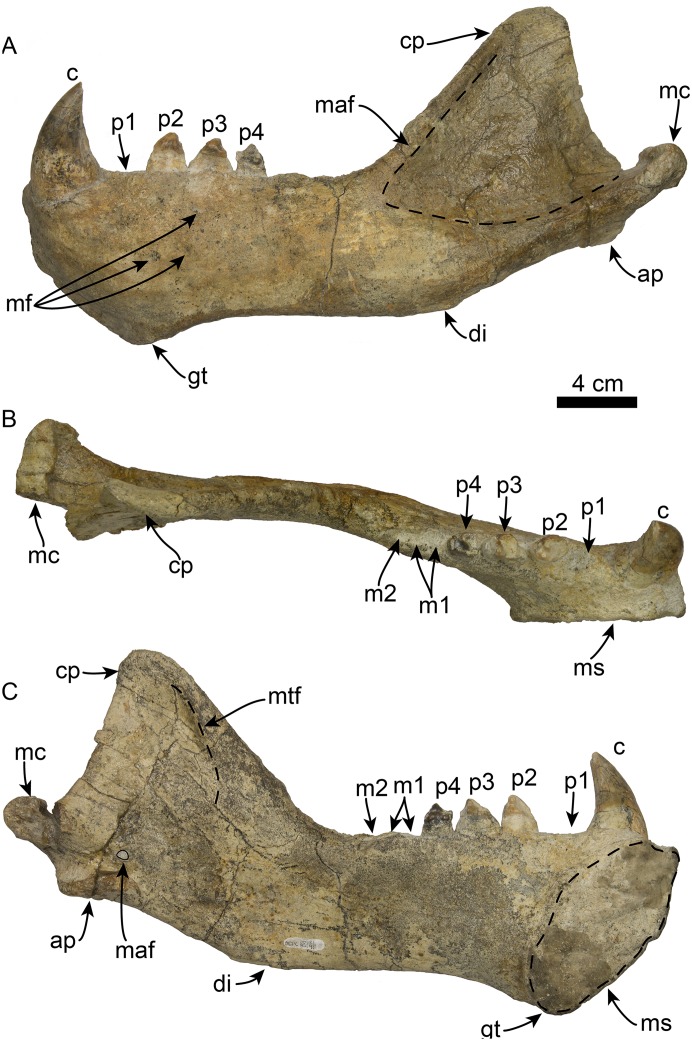
Mandible of Titanotaria orangensis n. gen. et sp. (OCPC 11141).Left mandible in lateral (A), occlusal (B), and medial (C), views. Abbreviations: ap, angular process; c, lower canine; cp, coronoid process; di, digastric insertion; gt, genial tuberosity; m1–2, lower molars 1–2; maf, masseteric fossa; mc, mandibular condyle; maf, mandibular foramen; mf, mental foramina; ms, mandibular symphysis; mtf, mandibular temporal fossa; p1–4, lower premolars 1–4.